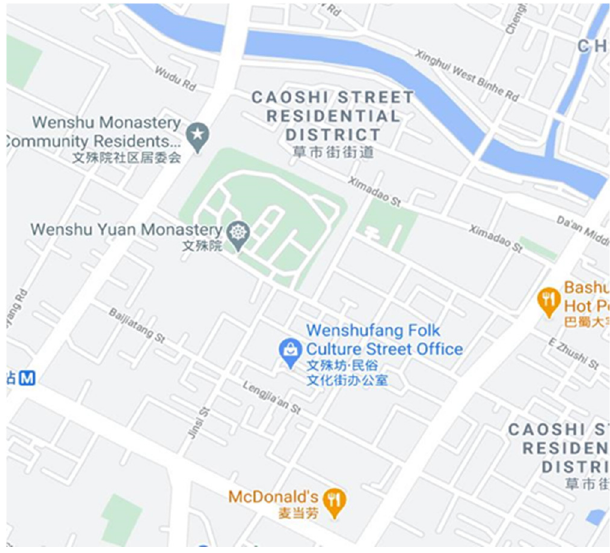
Figure 1. Wenshu Plaza and Wenshu Monastery. (Liao and Chen